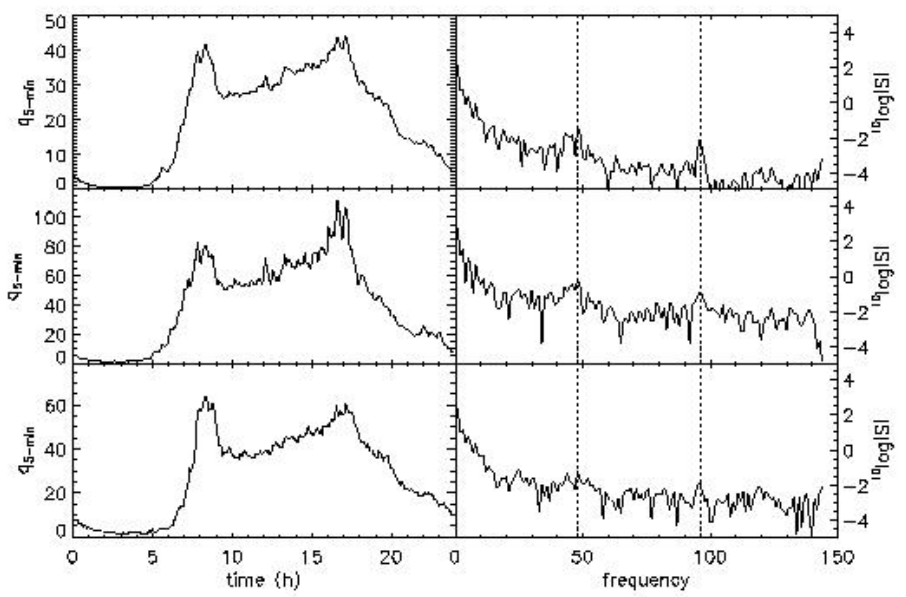
Figure 6. Short term variations in travel demand. ctra (right). The dotted lines in the right panel